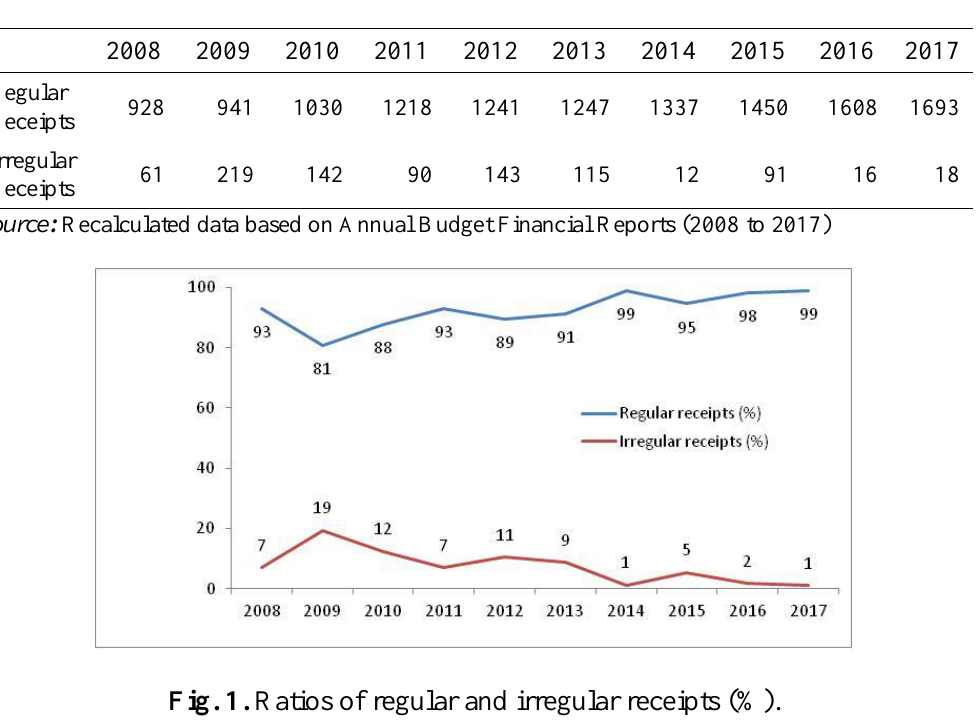
Fig. 1. Ratios of regular and irregular receipts